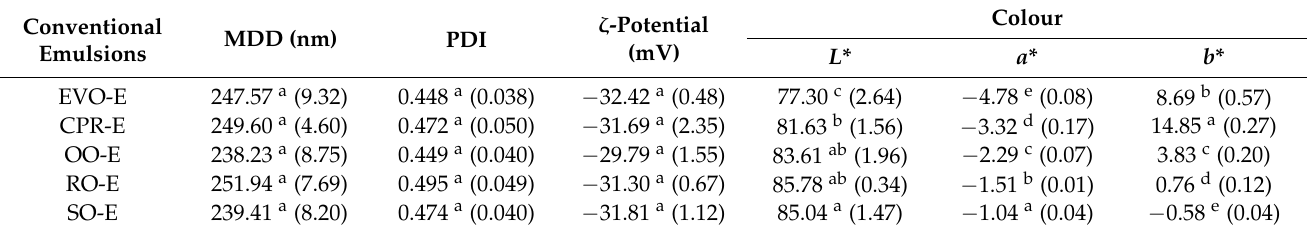
Indicated values are reported as means (standard deviation). Values with the different superscript letters are significantly different ( p < 0.05) between samples in the same column.